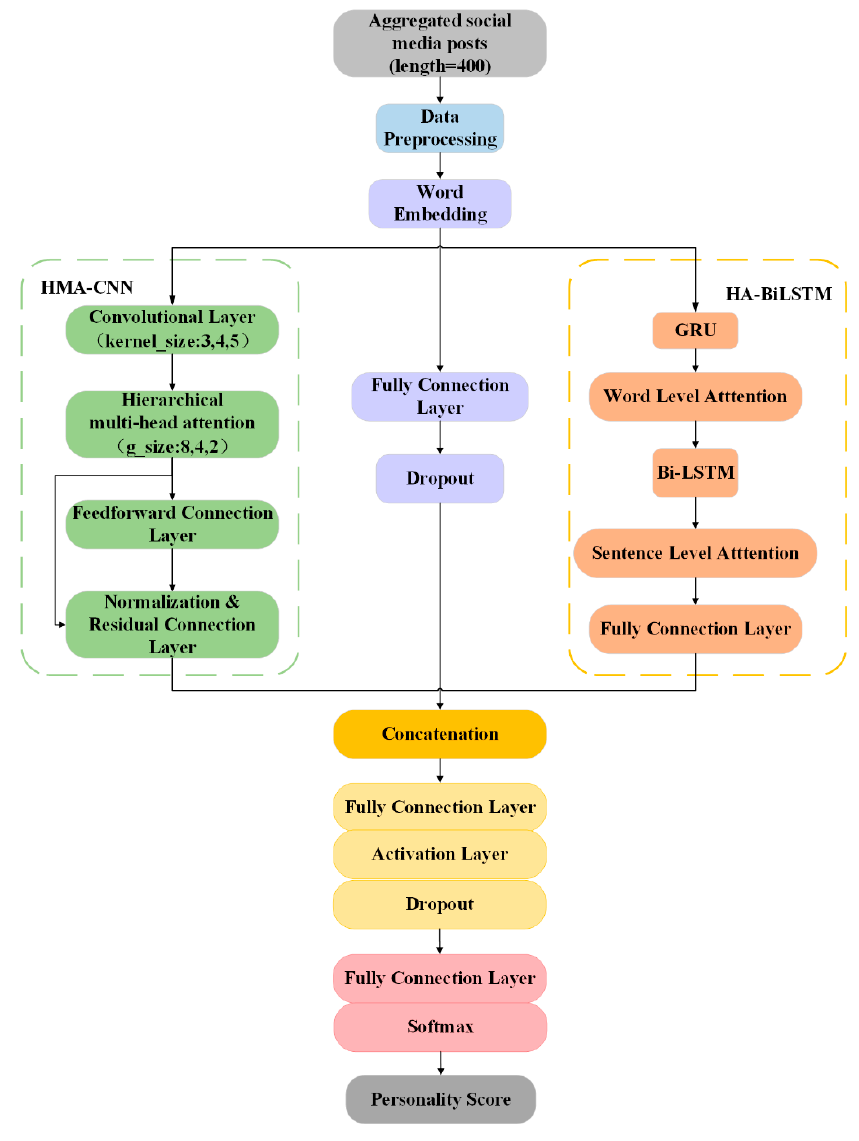
Figure 1. Model flowchart.